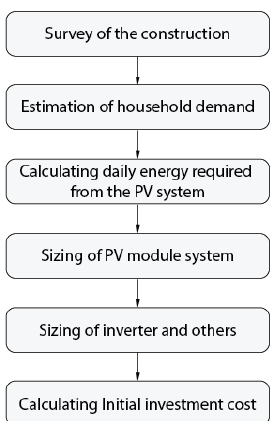
Figure 2. Procedures for Rooftop Solar System